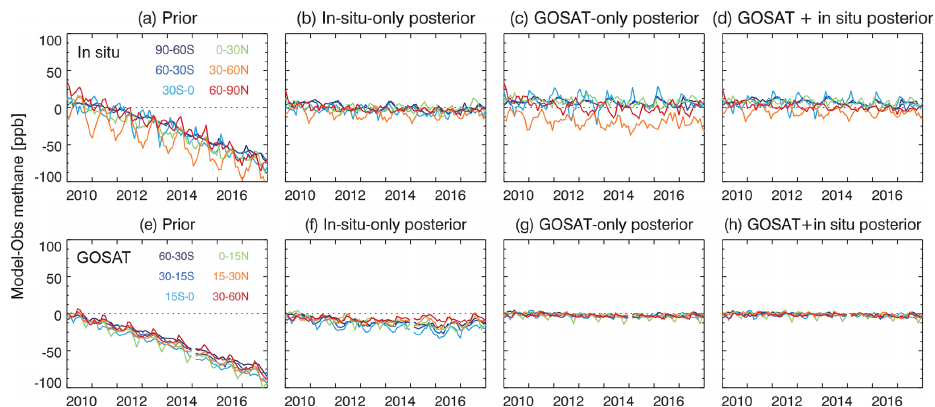
Figure 6. Ability of the inversions to fit the in situ methane observations and GOSAT satellite observations. Panels (a) – (d) show the monthly time series of the differences between observed and simulated in situ methane concentrations averaged over different latitude bands from 2010–2017. Panels (e) – (h) are the same as panels (a) – (d) but for GOSAT methane concentrations.